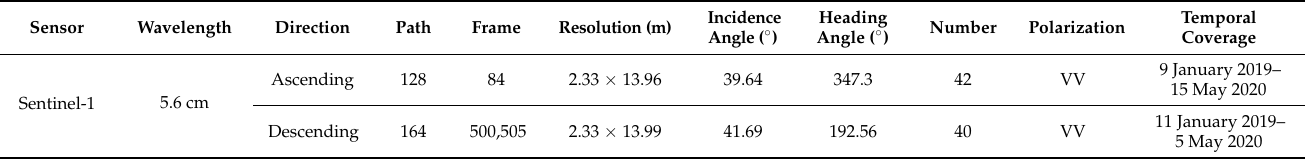
Table 1. Parameters of radar images used in the